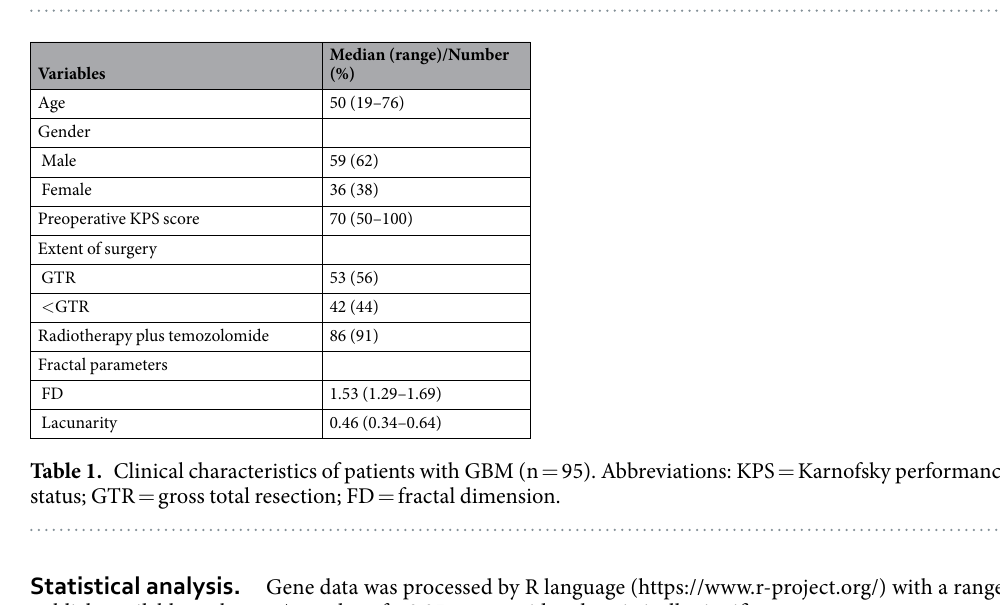
Figure 1. Segmentation and fractal analysis procedures for the analysis of necrotic patterns in glioblastoma. ( A ) A post-contrast T1-weighted magnetic resonance image of a representative patient with glioblastoma. ( B ) Segmentation of the tumor (green mask) and necrotic ROIs (red mask). ( C ) The necrotic ROIs are extracted with the tumor ROIs as the border. ( D ) Fractal analysis was performed by using the box-counting method.